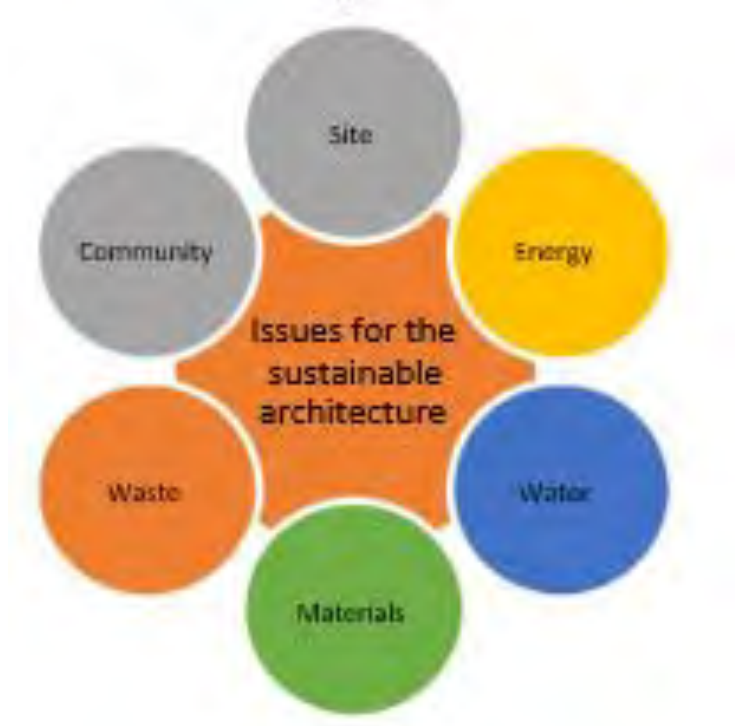
Figure 2. Outlinessix issues for the sustainable architecture andsustainable building.